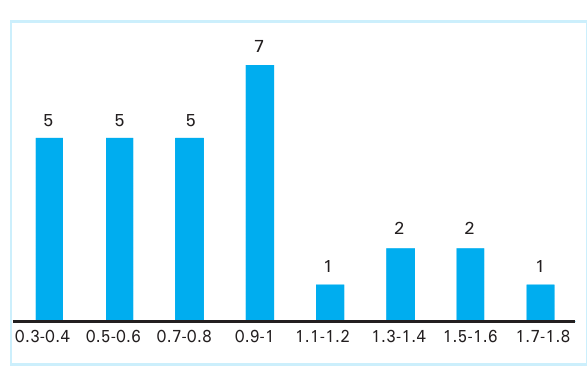
Figure 2. Bar Diagram showing the number of patients according to